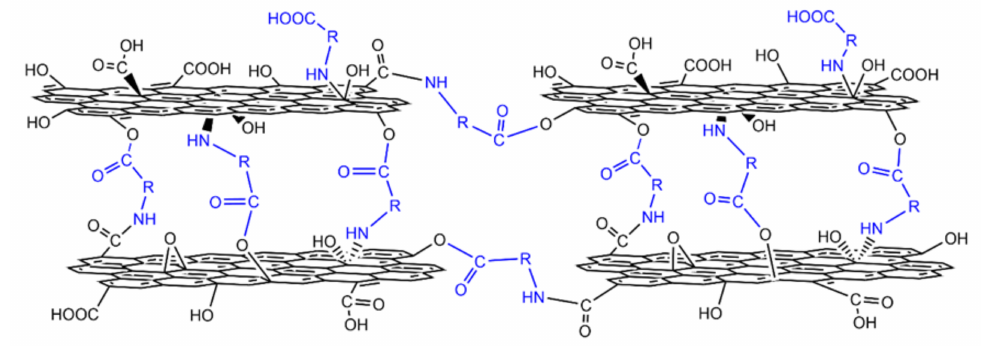
Figure 6. Microstructure model of GOM cross-linked with amino acids.